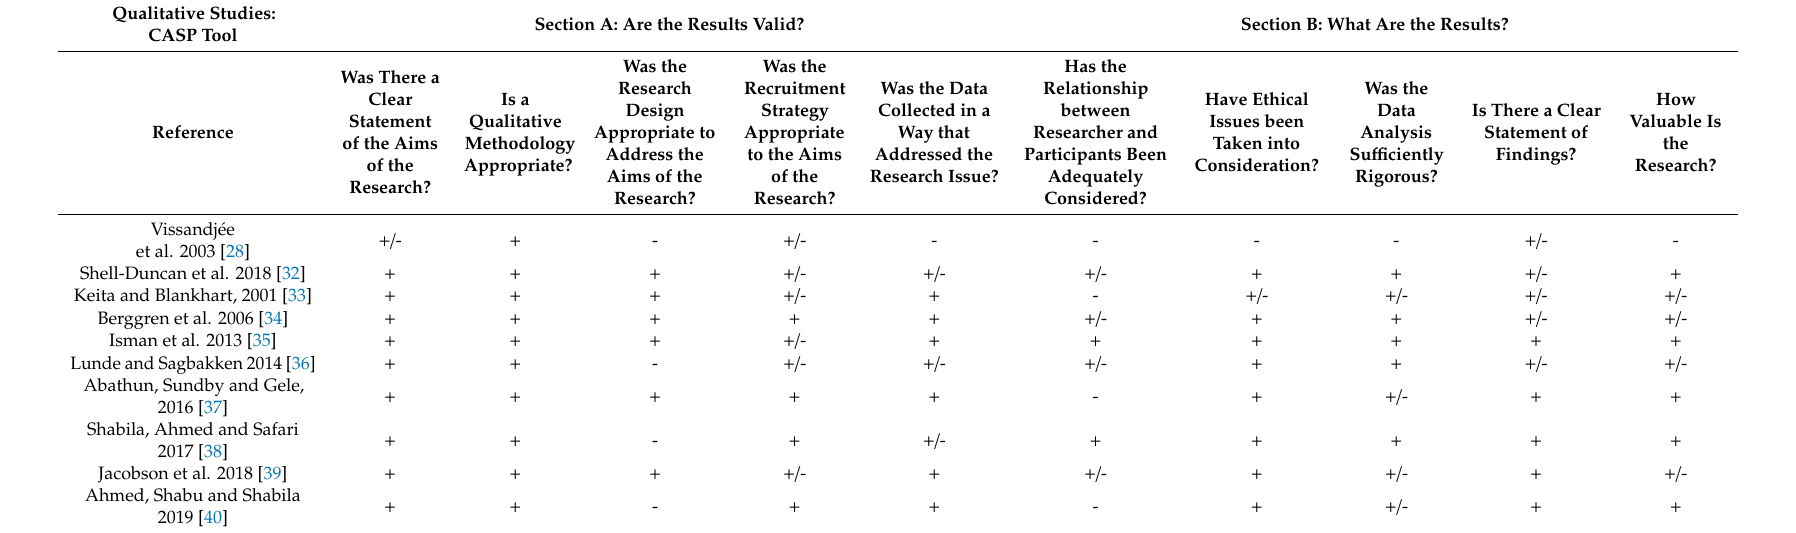
Table 3. Critical appraisal for qualitative studies using the Critical Appraisal Skills Programme (CASP)